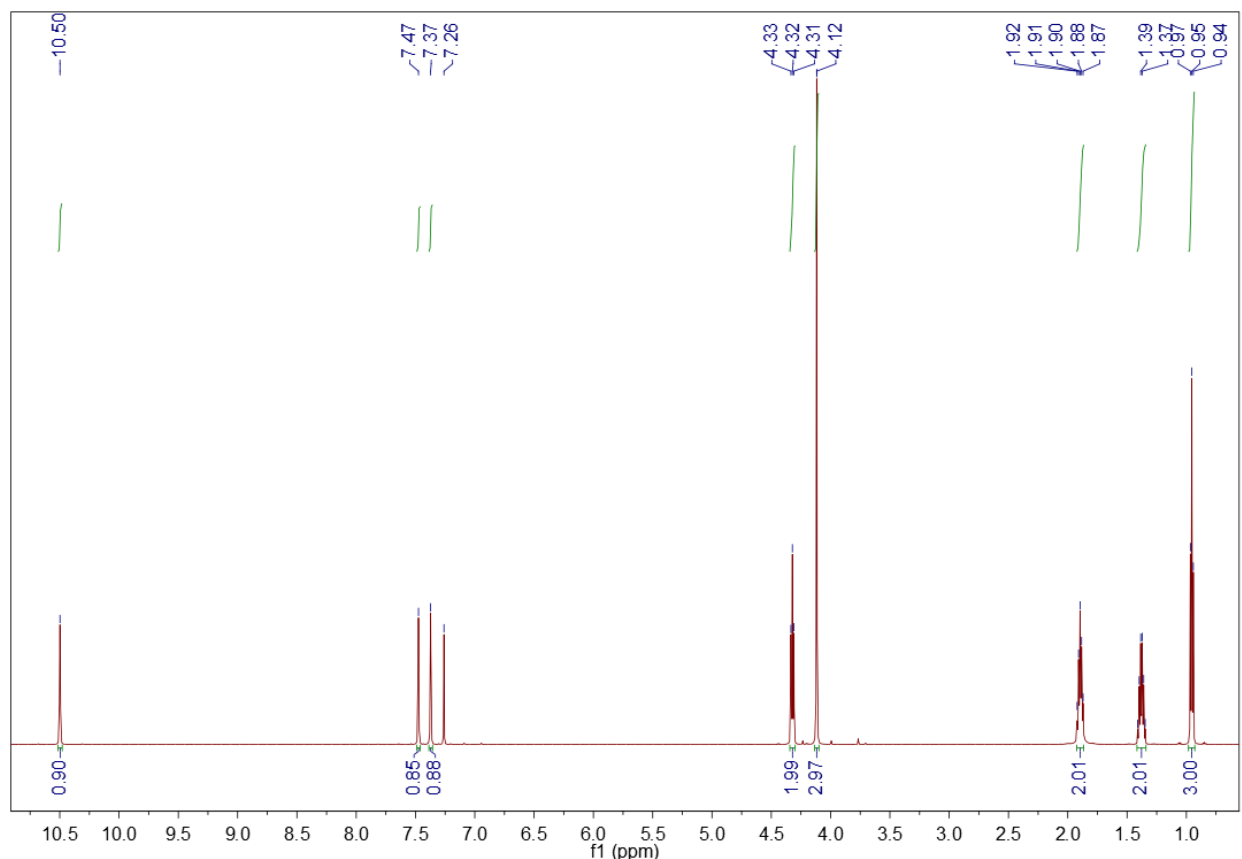
Figure 4. 1 H NMR spectrum of the fresh [BMIM][Br]. Sample of 10 mg in 0.7 mL deuterated chloroform, 600 MHz [45].